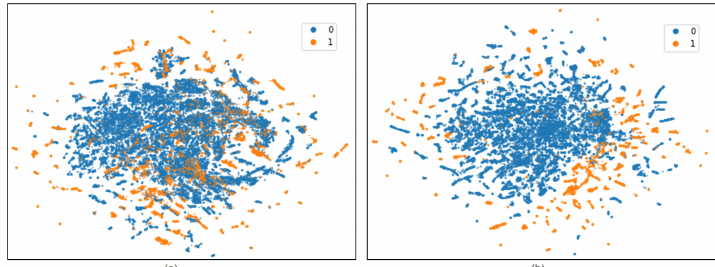
Figure 4. t-SNE results of samples where 0 denotes normal samples plotted in blue, and 1 denotes NTL samples plotted in orange. ( a ) samples based on raw SM data. ( b ) samples based on raw SM data and electricity measurement